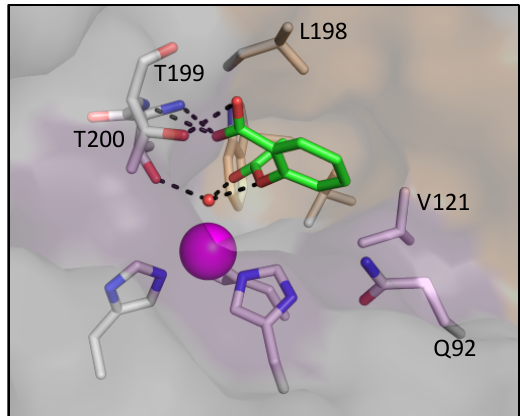
Figure 3. Structure of Aspirin modeled into the active site of CAII. The hydrophobic face of CAII is shown as orange surface while the hydrophilic face is shown as violet. Zinc is depicted as a magenta sphere with critical residues shown in sticks. Bound Aspirin is shown in pink sticks. V134 and W204 are unlabeled for clarity.